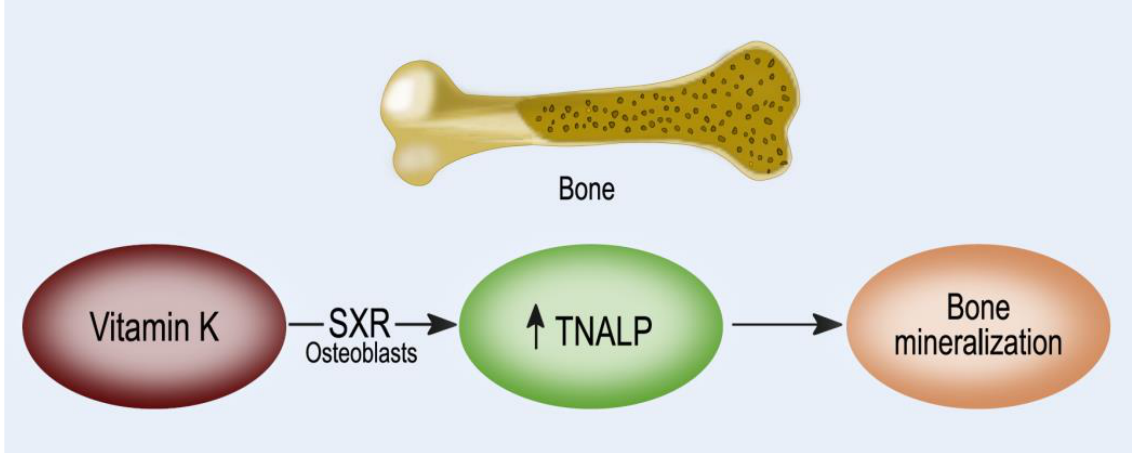
Figure 4. Vitamin K action as a ligand for the steroid and xenobiotic receptor (SXR).